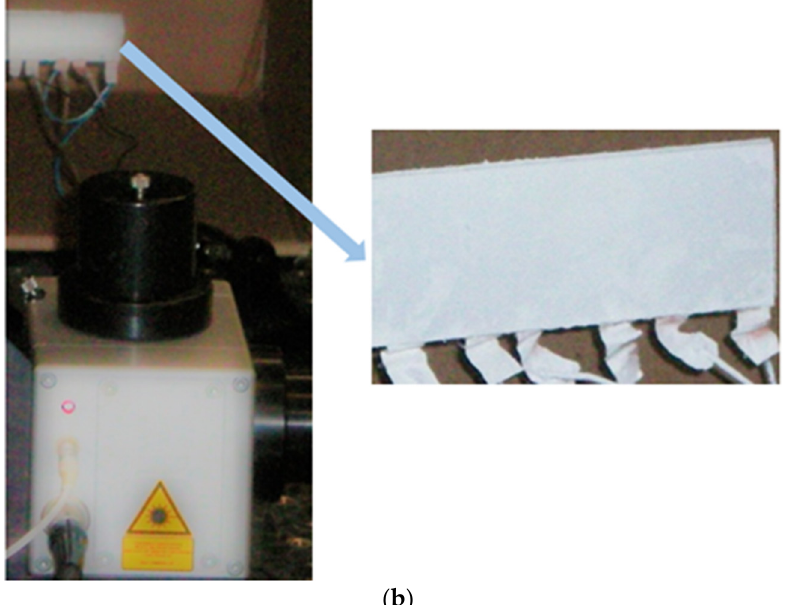
Figure 5. ( a ) Schematic composite benchmark and ( b ) experimental model with zoomed view of the